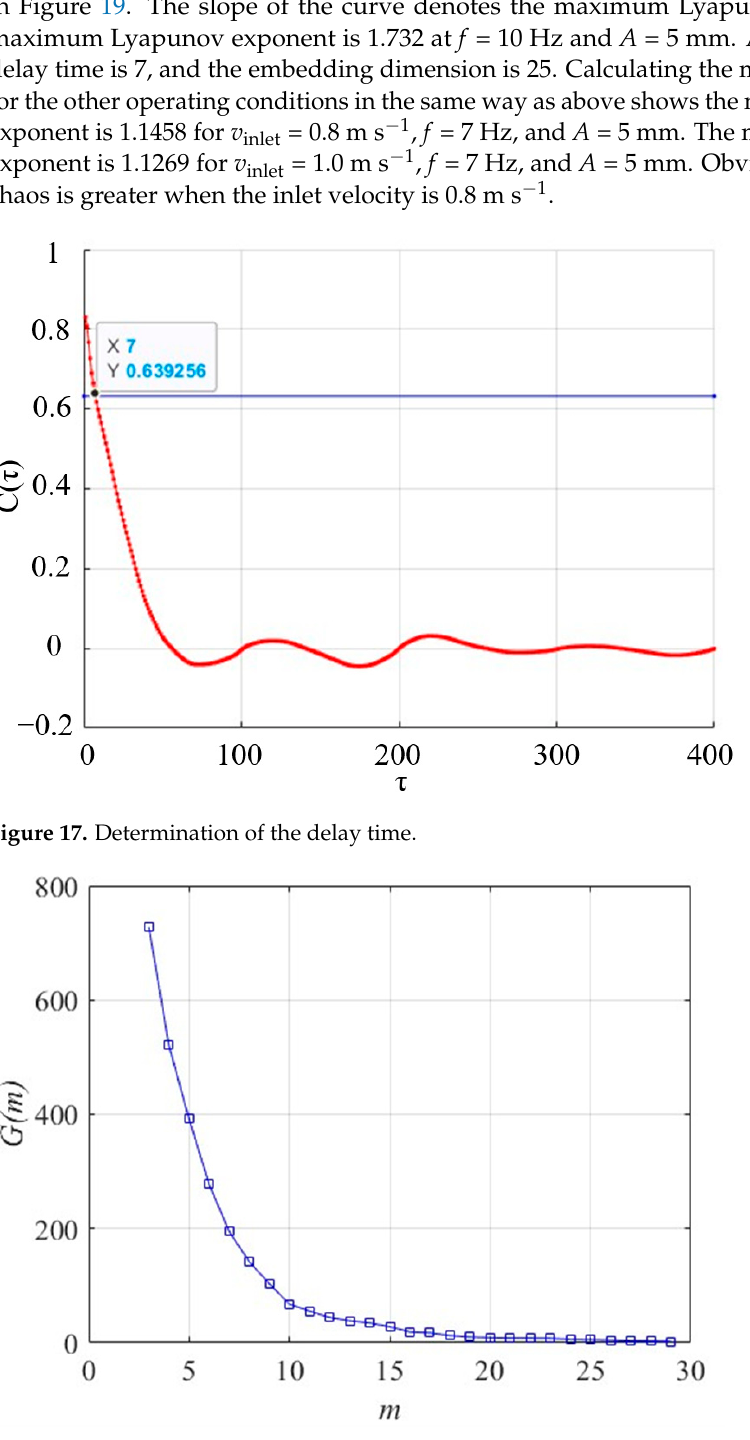
Figure 18. Associated dimensions.